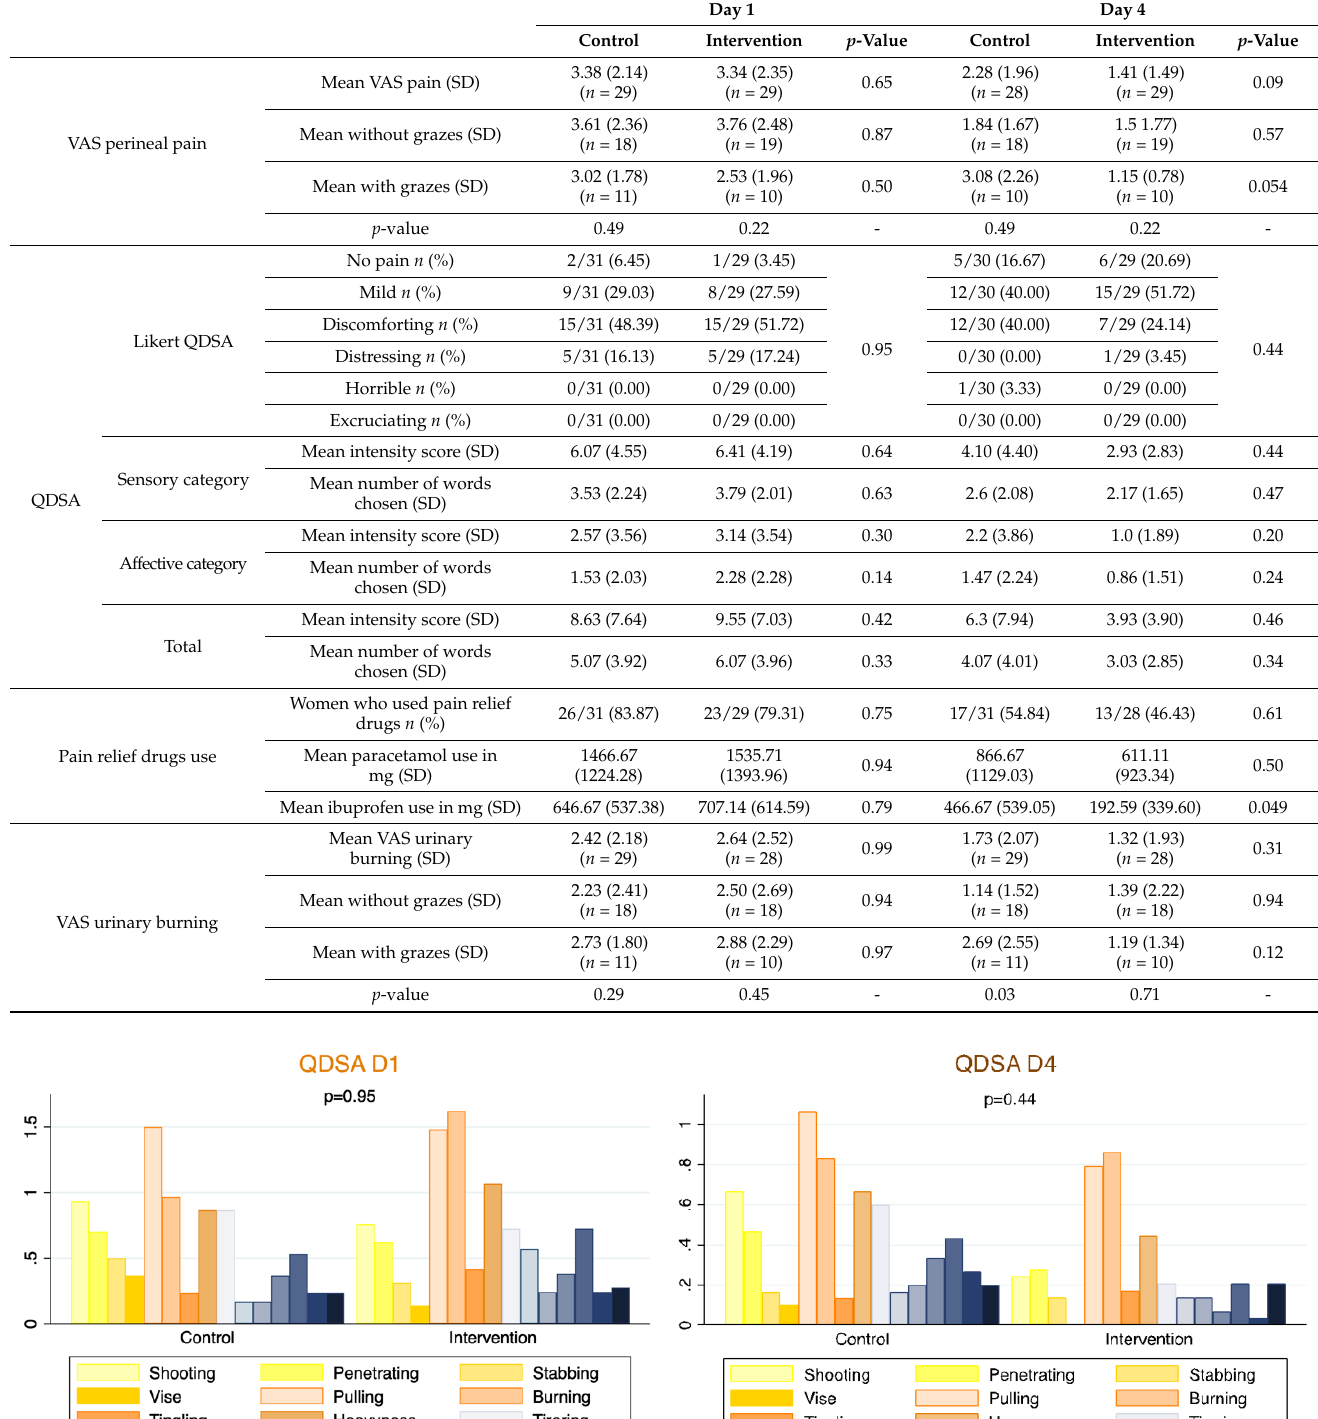
Table 3. Comparison primary and secondary outcomes between two groups at Day 1 and 4 postpartum.